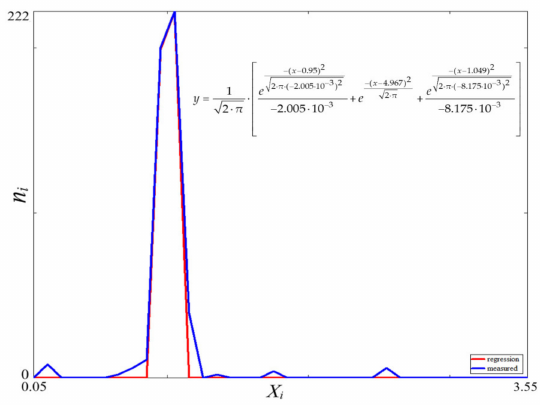
Figure 11. Diagram of the studied row unit’s sowing precision (in stationary conditions) for the density of 50,000 corn plants · ha − 1 and the working speed of 4 km · h − 1 , repetition